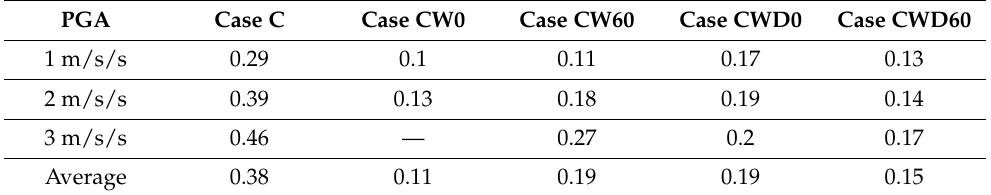
Figure 18. Acceleration response of the SCS surface under simulated wave: ( a ) Maximum acceleration for different PGAs; ( b ) acceleration time histories under PGA 2 m/s/s. Table 4. The response ratio of maximum acceleration to the Case CB under major PGAs.